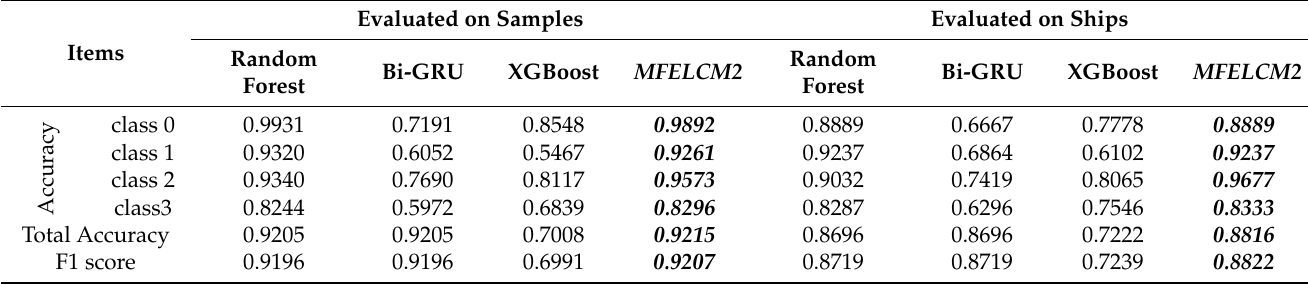
Figure 35. ( a ) Confusion matrix of samples (MFELCM2); ( b ) Confusion matrix of ships (MFELCM2). Table 17. Performance evaluation of base classifiers and MFELCM2.